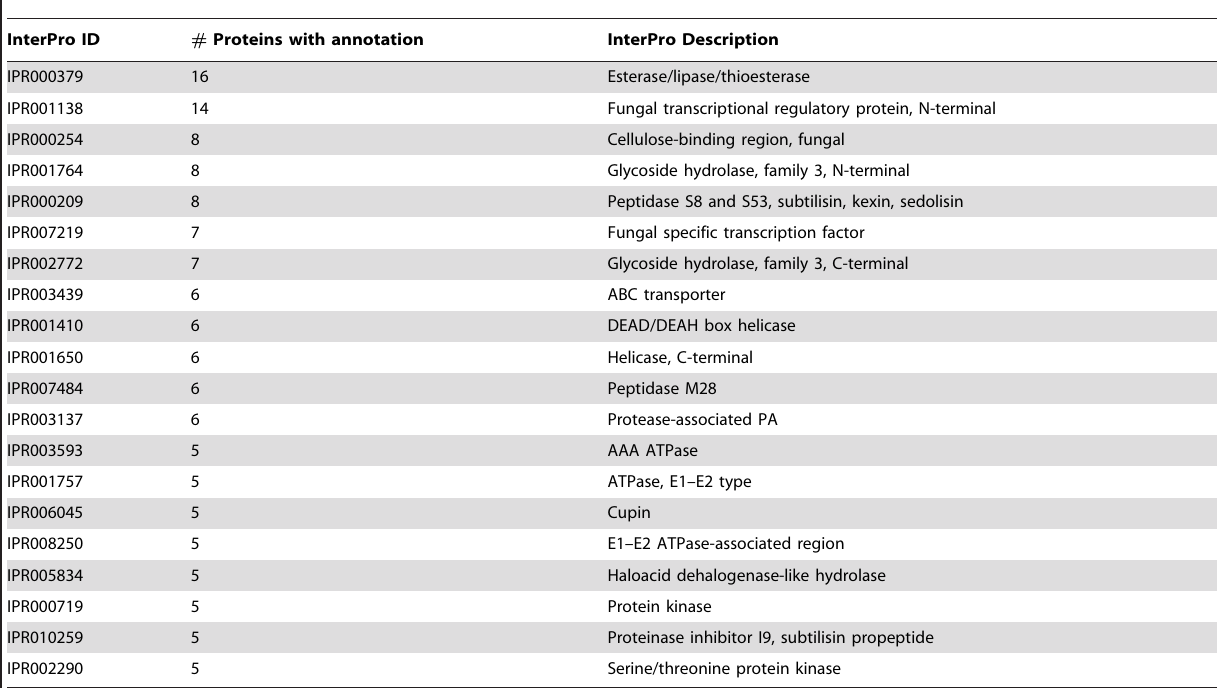
Table 2. Most Abundant InterPro IDs Identified in MudPIT analysis.